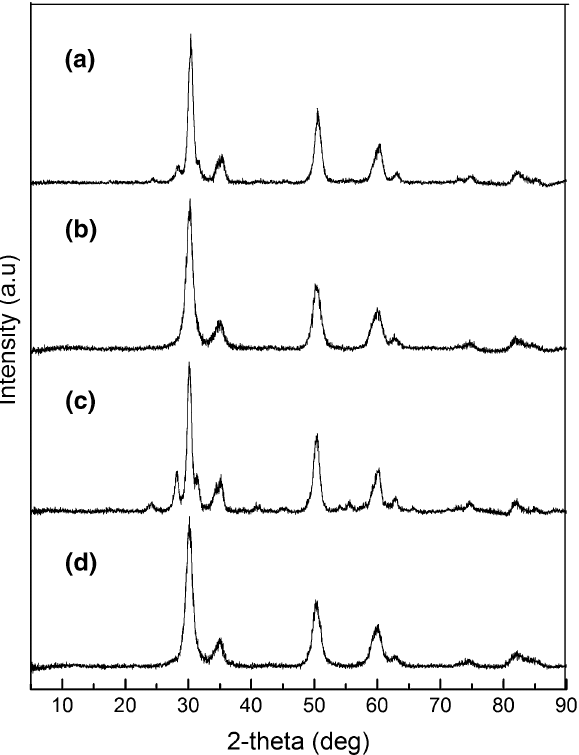
Fig. 5 Diffractogram of zirconia prepared with and without sulfate or CTAB. a Z, b ZS, c MZ, and d